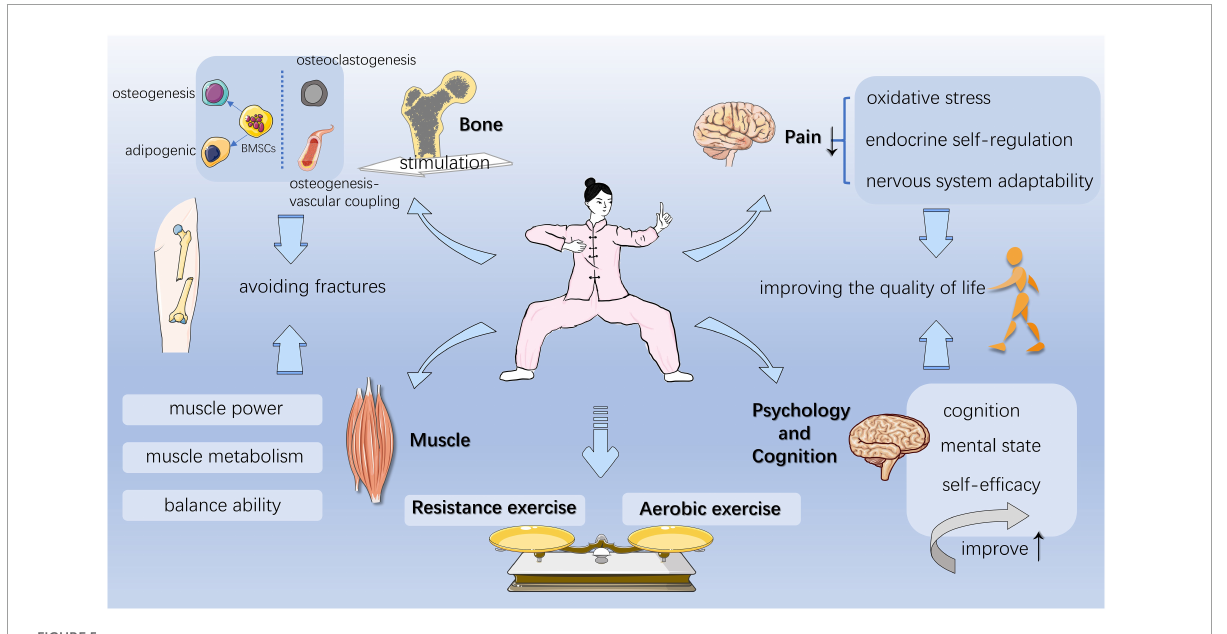
FIGURE5 The potential mechanism of Baduanjin (BDJ) exercise.